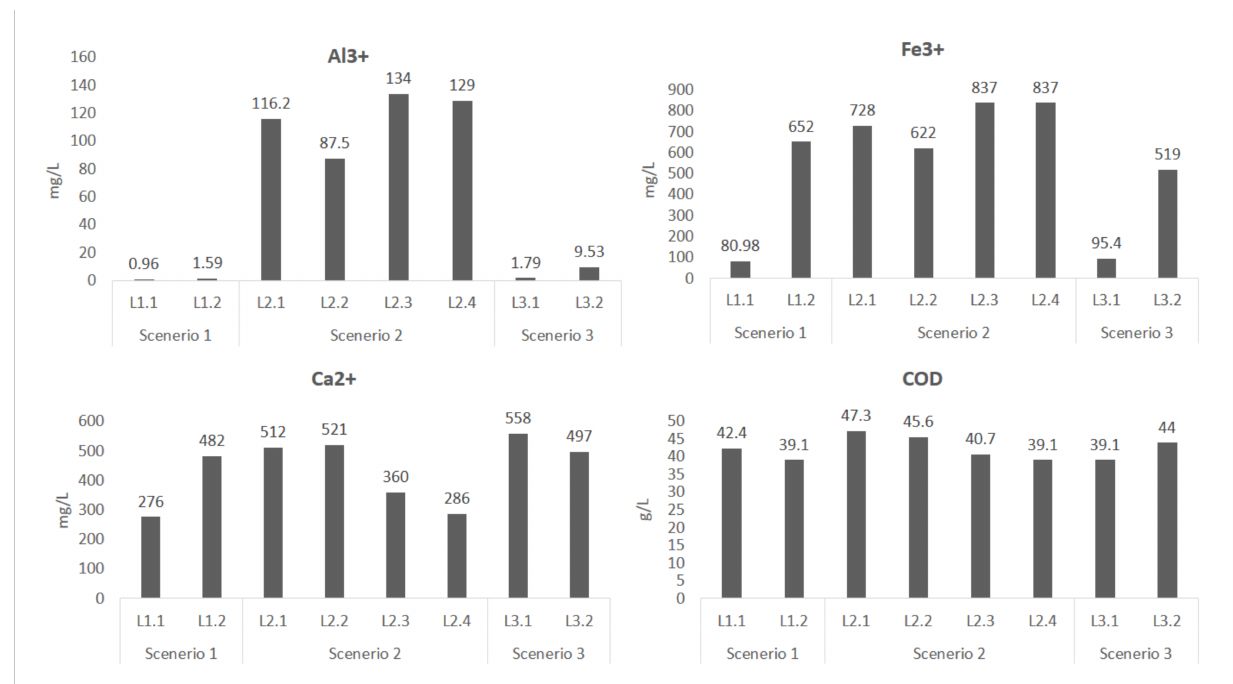
Figure 3. Metal ions’ concentrations and COD of the leachate after solid–liquid separation.